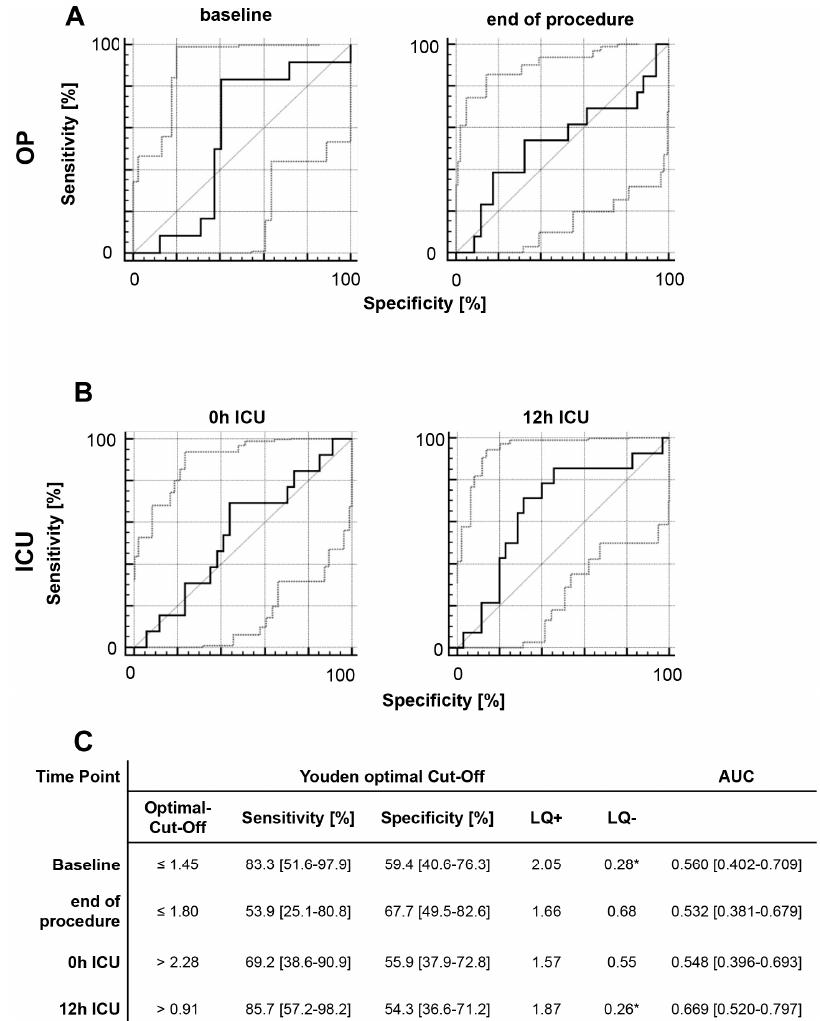
Figure 4. ROC analysis of perioperative MIF levels and acute kidney injury. ROC analysis was performed to evaluate the diagnostic capacities of ( A ) perioperative MIF levels and ( B ) MIF levels during ICU admission with regard to acute kidney injury (AKI) based on a serum creatinine increase of >50% within 48 h after ICU admission. If an elevated MIF value indicates AKI, the ROC curve should be farther from the bisecting line (Sensitivity = 1 − Specificity). ( C ) Sensitivity (Se), specificity